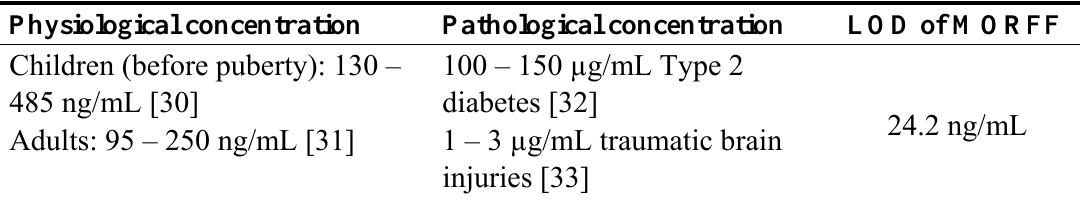
Table 1. Physiological and pathological concentrations of IGF-1 in humans (examples) and current LOD of